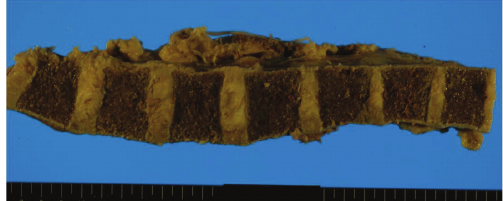
Figure 4: Normal gross findings of the vertebral column. Neither osteolytic nor osteosclerotic lesions are present.